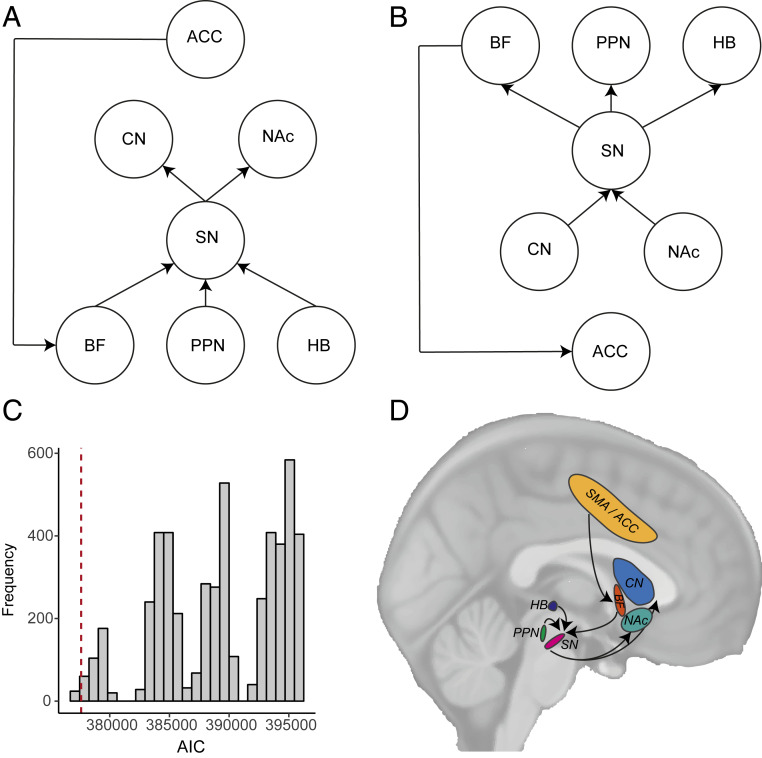
Decisions about when to act are constructed within a cortico-subcortical circuit. (A) The hypothesized model in which activity in CN and NAc is influenced by SN; activity in SN is influenced by BF, PPN, and HB; and ACC influences BF (for estimates of path coefficients, see SI Appendix, Table S2). (B) Alternative model. The hypothesis-driven model fits the data better than an alternative model in which the directions of paths were reversed. (C) Randomly permuting the position of each ROI in the hypothesis-driven model produced a distribution of AICs. The AIC of the hypothesis-driven circuit (dashed red line) was positioned in the 0.6th percentile of this distribution. (D) A schematic of a cortico-subcortical circuit for decisions about when to act. See also SI Appendix, Fig. S8.